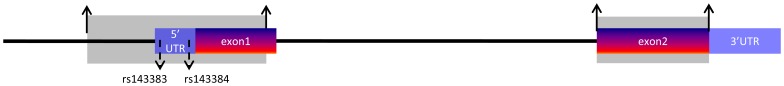
Structure of the human GDF5 gene structure.The human GDF5 gene is composed of two exons. The two regions sequenced in this study are denoted by the two rectangles.